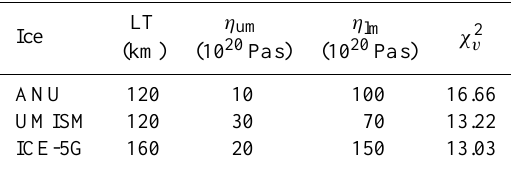
Table 2. Parameters for the earth models that best fit the Bifrost ver- tical velocities, from Fig. 7, for all three ice sheet